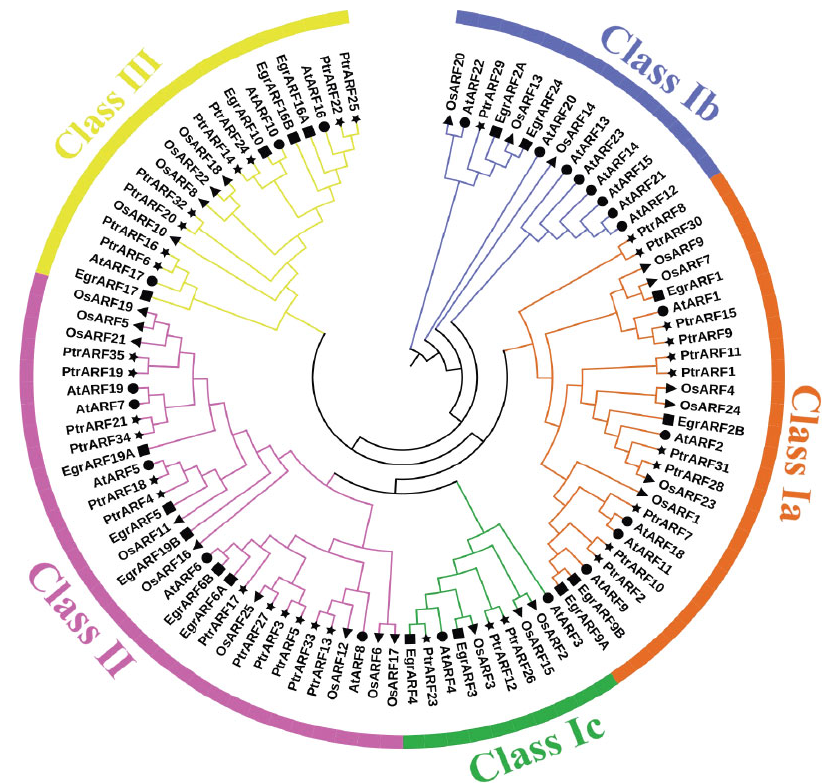
Figure 1. Phylogenetic analysis of the ARF proteins from P. trichocarpa , A. thaliana , E. grandis , and O. sativa . The conserved domain (PF02362) sequences of 35 PtrARF proteins, 23 AtARF proteins, 17 EgrARF proteins, and 25 OsARF proteins were aligned with Clustal X 2.0; the phylogenetic trees were constructed with MEGA 5.2 using the neighbor-joining (NJ) method and 1000 repetitions of bootstrap tests. All ARF genes were classified into three classes with different colors. Four species were represented by four symbols, respectively. Star, P. trichocarpa ; round, A. thaliana ; square, E. grandis ; triangle, O. sativa